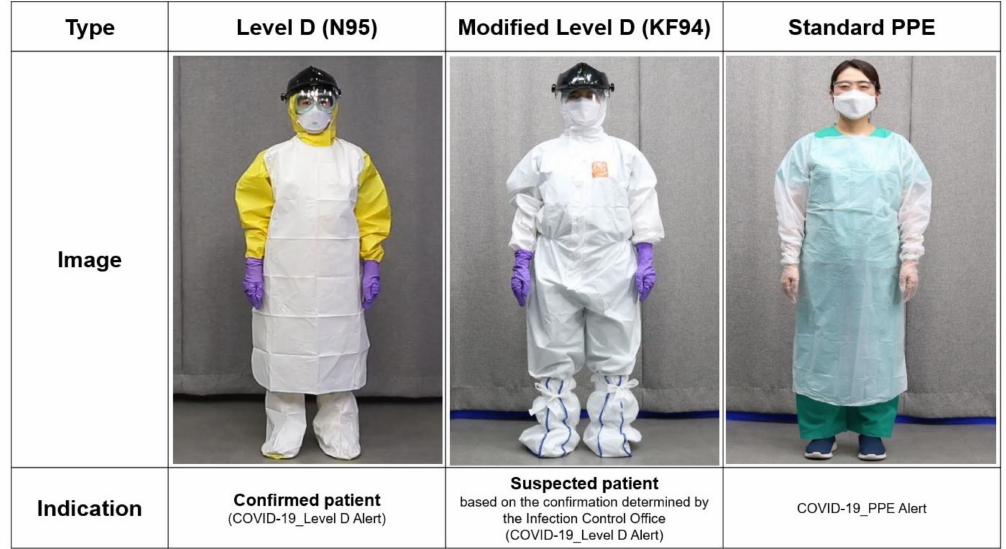
Figure 3. Types of PPE used at AMC. PPE: personal protective equipment; AMC: Asan Medical Center; COVID-19: coronavirus disease